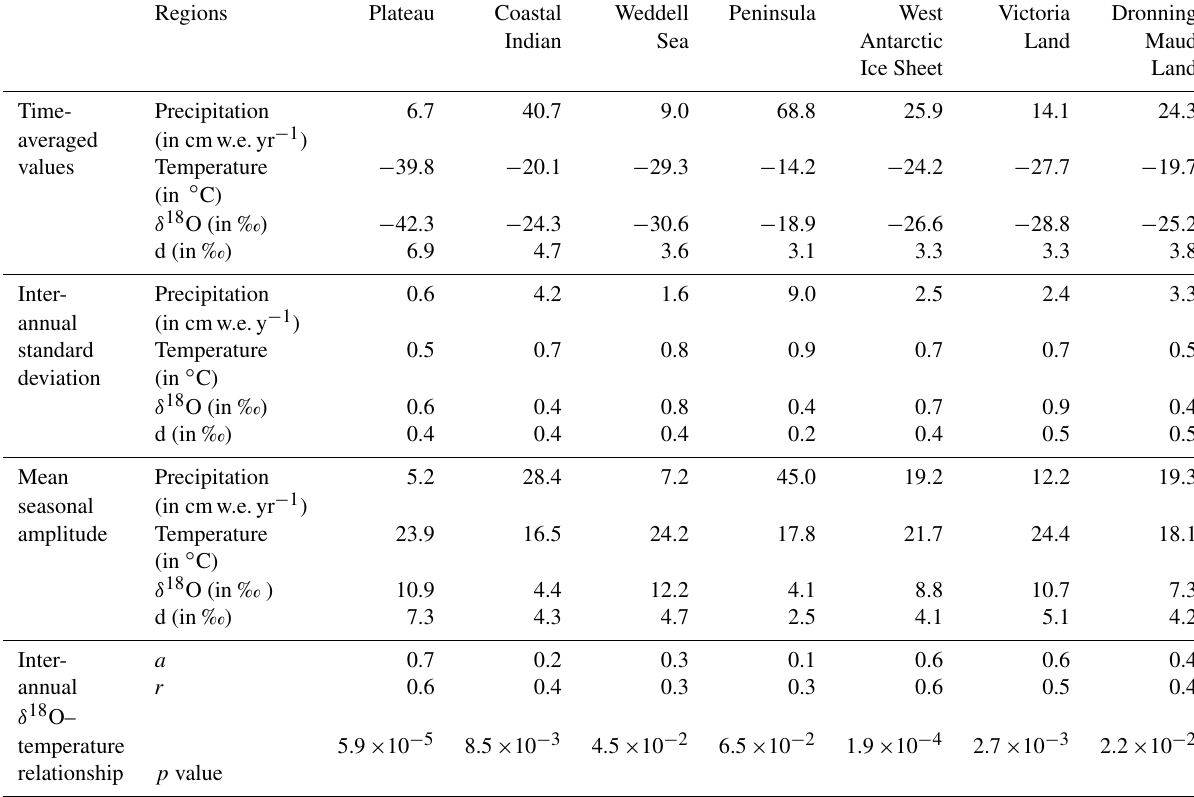
Table 10. Exploration of the ECHAM5-wiso model outputs (1979–2013) for seven Antarctic regions: east plateau, coastal Indian, Wed- dell Sea, peninsula, West Antarctic Ice Sheet, Victoria Land, and Dronning Maud Land (7). For each of the variables precipitation (in mmw.e.yr − 1 ), temperature (in ◦ C), δ 18 O (in ‰), and d (in ‰), we regionally averaged the annual mean values (lines 1 to 4), the inter- annual standard deviation (lines 5 to 8), and the mean seasonal amplitude (lines 9 to 12). Finally, we calculated the statistics of the inter- annual δ 18 O–temperature linear relationship: the slope (noted as “ a ”, in ‰ ◦ C − 1 ), the correlation coefficient (noted as “ r ”), and the p value for each region.